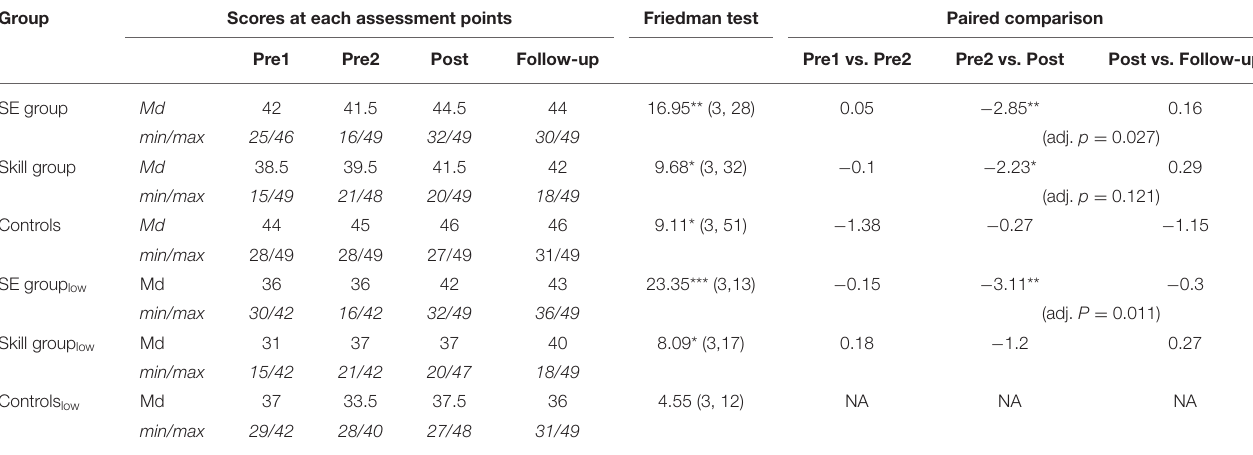
TABLE 2 | Changes in self-efficacy among two intervention groups and controls (RQ1). Group Scores at each assessment points Friedman test Paired comparison Post Follow-up Pre1 vs. Pre2 Pre2 vs. Post